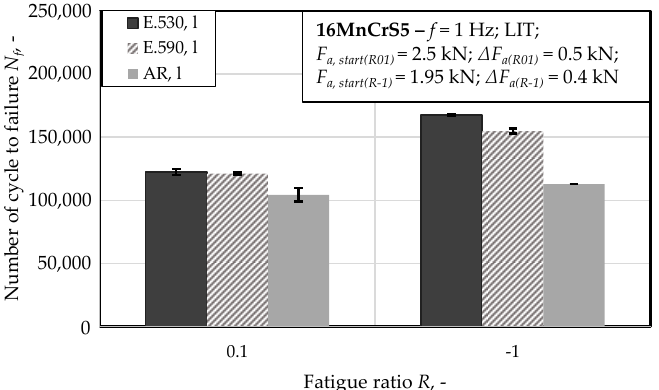
c ) induced under cyclic compression load paths in the bulged area of the